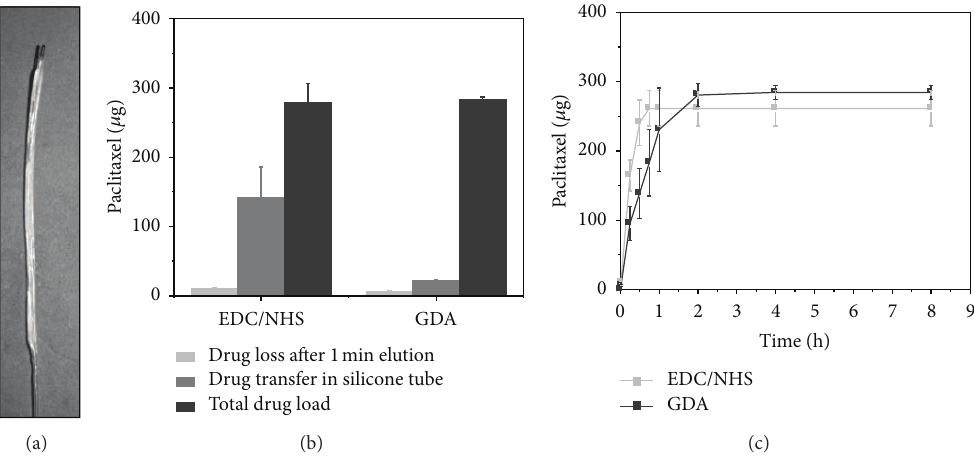
Figure 7: (a) Representative photograph of an EDC/NHS-crosslinked HA coating on GPTMS-modified PA12 balloon catheter, (b) paclitaxel loss after one minute elution in DPBS/Tween-20, paclitaxel transfer upon expansion in silicone tube (30s, 7 bar) and total drug load of EDC/NHS- and GDA-crosslinked HA coatings on GPTMS-modified PA12 balloon catheter ( 𝑛 = 4 ) at 23 ± 2 ∘ C, all data shown as mean ± SD, and (c) in vitro paclitaxel release from EDC/NHS- and GDA-crosslinked HA coatings on GPTMS-modified PA12 tubes ( 𝑛 = 3 ) in DPBS/Tween 20 at 23 ± 2 ∘